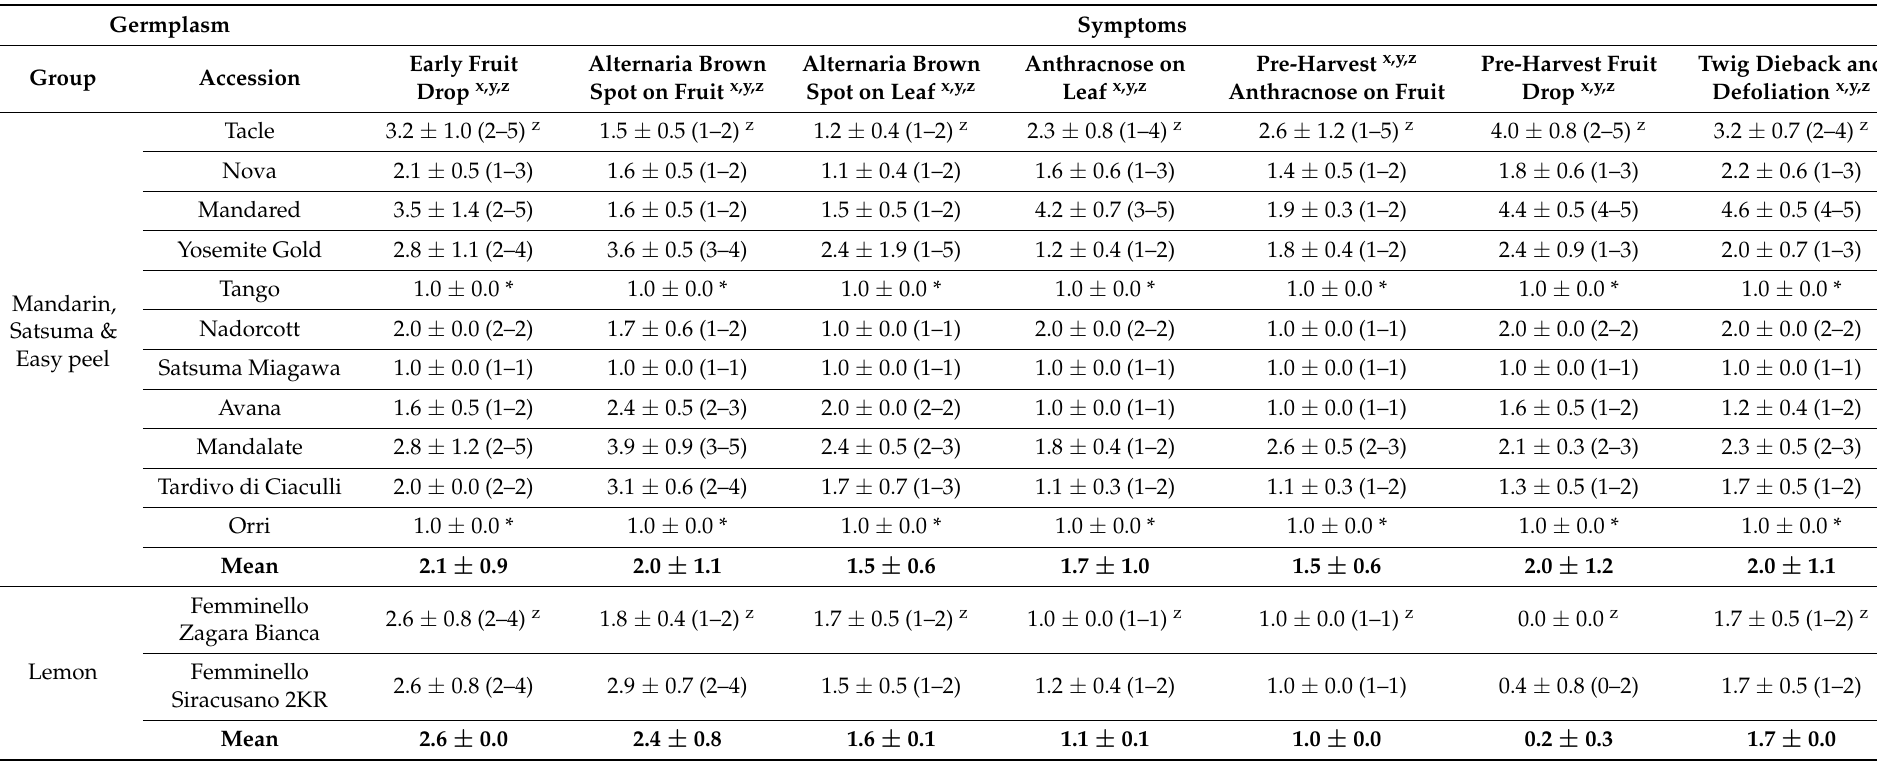
x Disease data for each cultivar/clone are the means of three replicates, each relative to three monitoring periods (2010–2013, 2014–2017, 2018–2020), obtained from 20 representative Citrus production areas (at least one area monitored over two periods) in eastern Sicily. y Mean disease scores were calculated according to an empirical 0-to-5 disease incidence scale taking into account the percentage of citrus organs in the canopy where 0 = healthy canopy; 1 = from 1 to 5% of infected fruit/leaves/twigs in the canopy; 2 = from 6 to 15% of infected fruit/leaves/twigs in the canopy; 3 = from 16 to 30% of infected fruit/leaves/twigs in the canopy; 4 = from 31 to 60% of infected fruit/leaves/twigs in the canopy, 5 = from 61 up to 100% of infected fruit/leaves/twigs in the canopy. z Data are followed by standard deviation value and